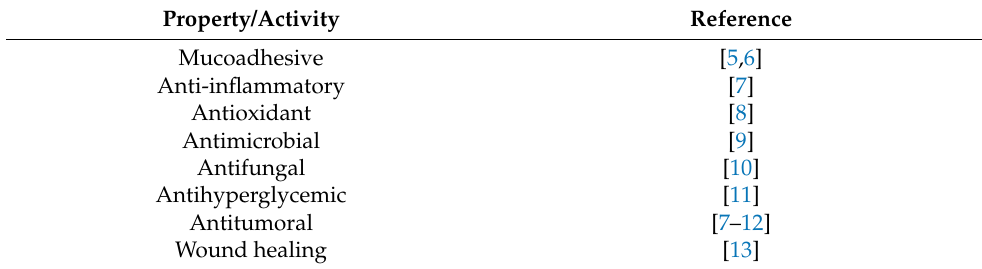
Table 1. The main properties of chitin and